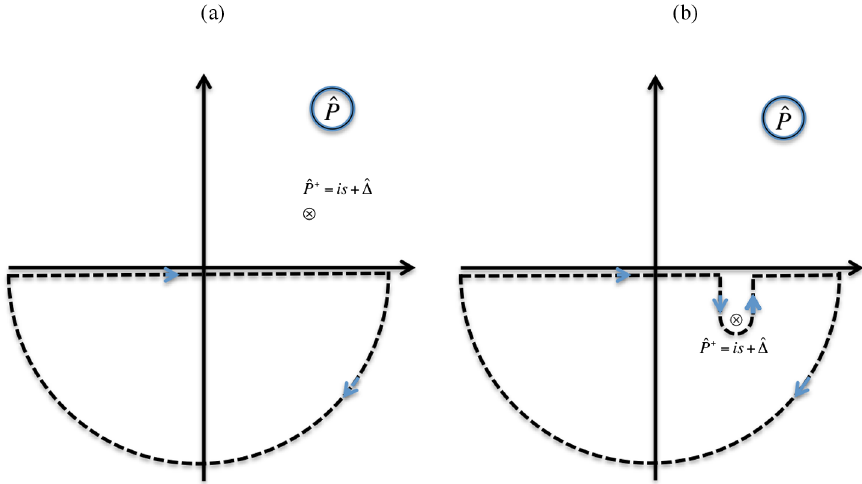
FIG. 2. (a) The integration contour for the evaluation of ^ D ð s Þ at Re ð s Þ > 0 . (b) The integration contour for the analytical continuation of ^ D ð s Þ into Re ð s Þ (cid:6) 0 .